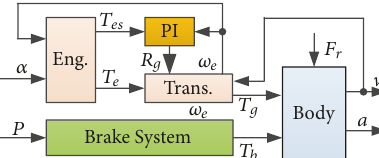
Figure 2: Vehicle longitudinal dynamics including a combustion engine, a continuous variable transmission (CVT), a hydraulic braking system, and a mechanical